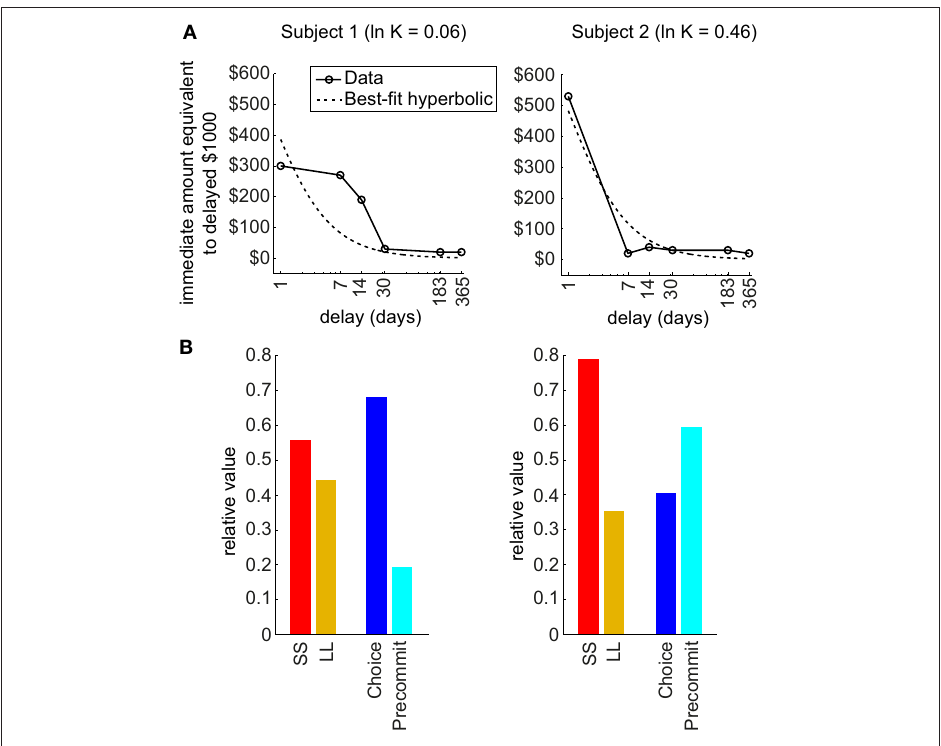
Figure 3 | Shape of discounting curve strongly influences precommitment. (A) The actual discounting curves of two individuals are shown in solid lines, and the best-fit hyperbolic curves are shown in dashed lines. These two subjects were both fit by a hyperbolic function with ln( K ) of approximately 0 (from a range of − 13 to + 4 across subjects). (B) Predicted precommitment behavior, based on actual discounting curve shape of each subject, using the